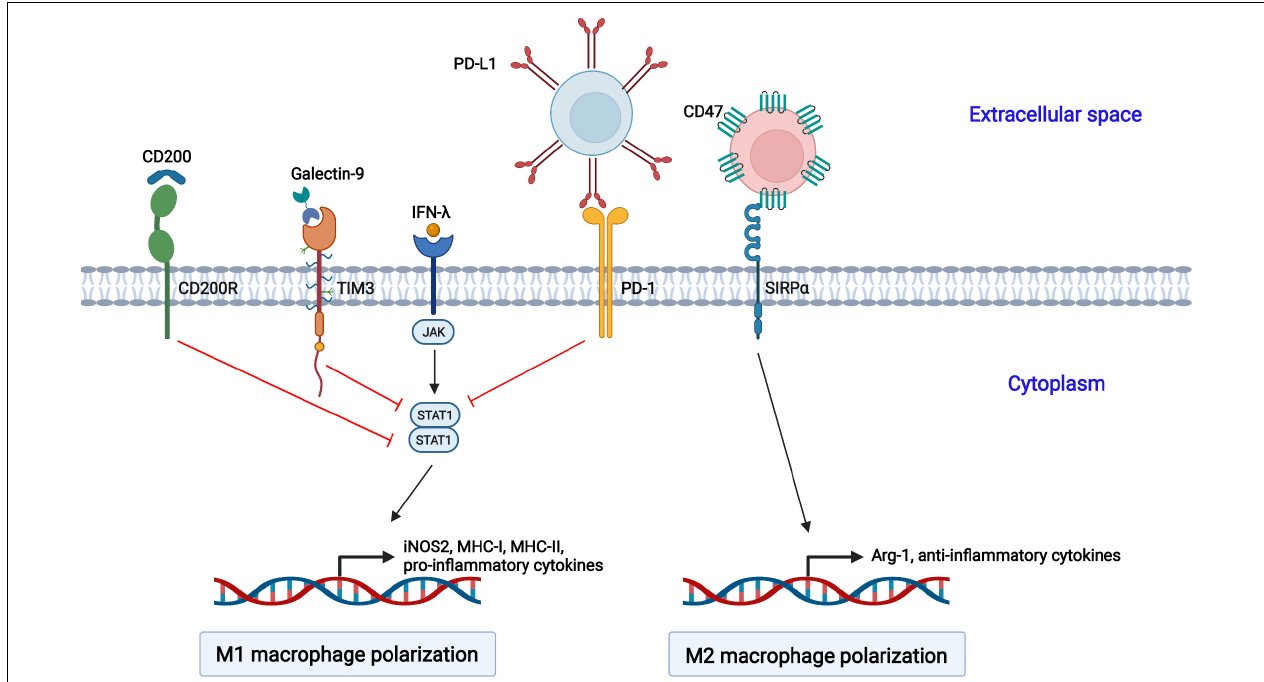
FIGURE 2 | Negative regulation of macrophage polarization by cellular inhibitory receptors. The activation of CD200R, TIM3, and PD-1 suppresses STAT1-mediated macrophage polarization toward the M1 phenotype. CD47 interacts with SIRP α on the cell surface of macrophages and promotes macrophage polarization toward the M2